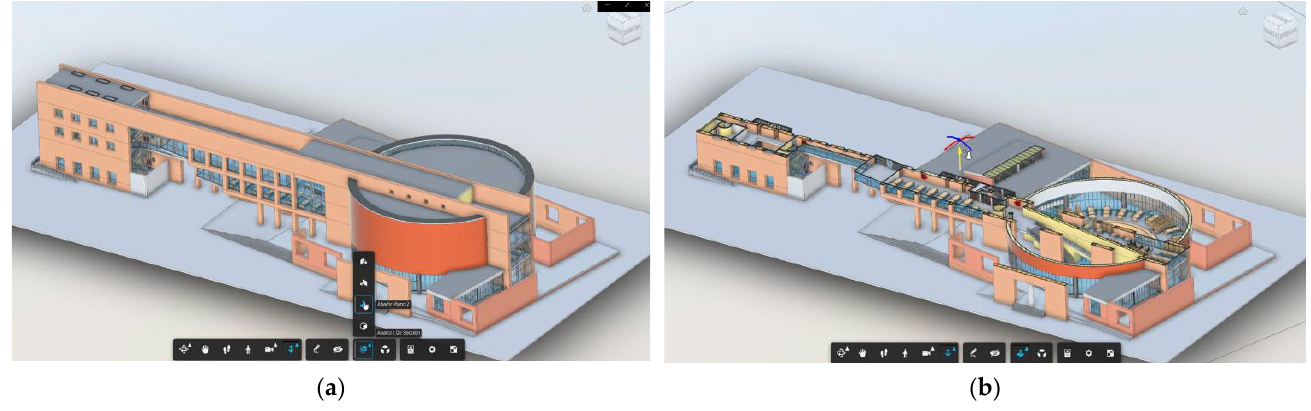
Figure 6. The 3D views of the full model ( a ) and a horizontal section ( b ) using one of the A360 tools.